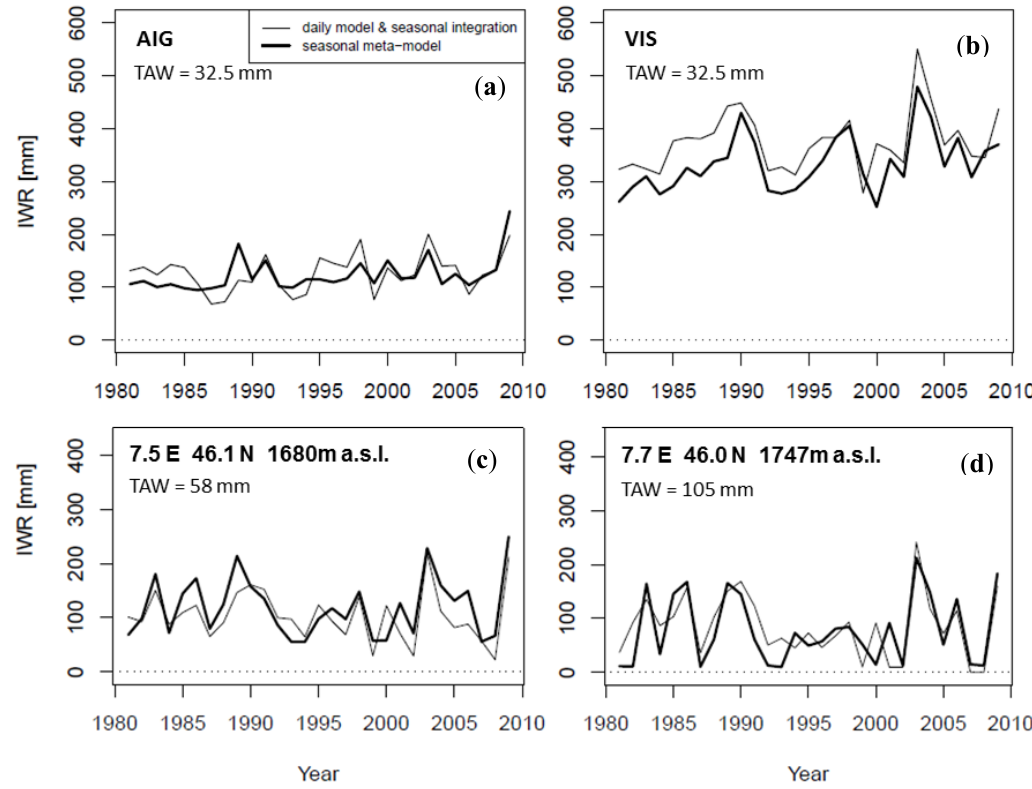
Figure 4. Time series of seasonal IWR for grassland at Aigle ( a ); Visp ( b ); and two of the verification sites near Evolène ( c ) and Zermatt ( d ). Thin lines represent results obtained with the daily point-scale model, and thick lines display the estimate given by Equations